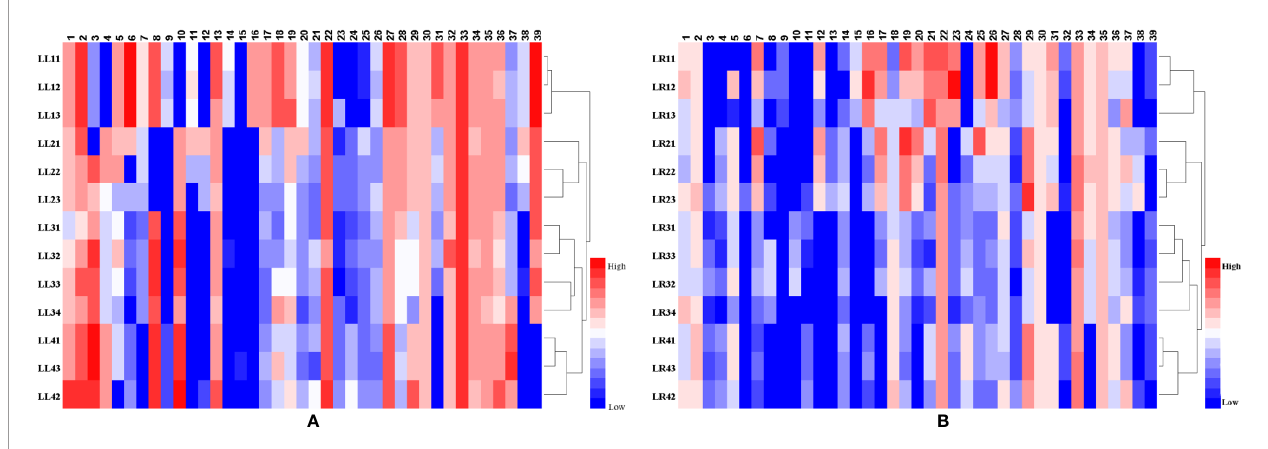
FIGURE 3 | The heat-map and HCA of differential metabolites from different parts ( A , leaf samples; and B , rhizome samples) of Acorus . LL, leaf sample; LR, rhizome sample; LL11 – LL13 and LR11 – LR13, A. calamus ; LL21 – LL23 and LR21 – LR23, A. tatarinowii ; LL31 – LL34 and LR31 – LR34, A. macrospadiceus ; LL41 – LL43 and LR41 – LR43, A. gramineus